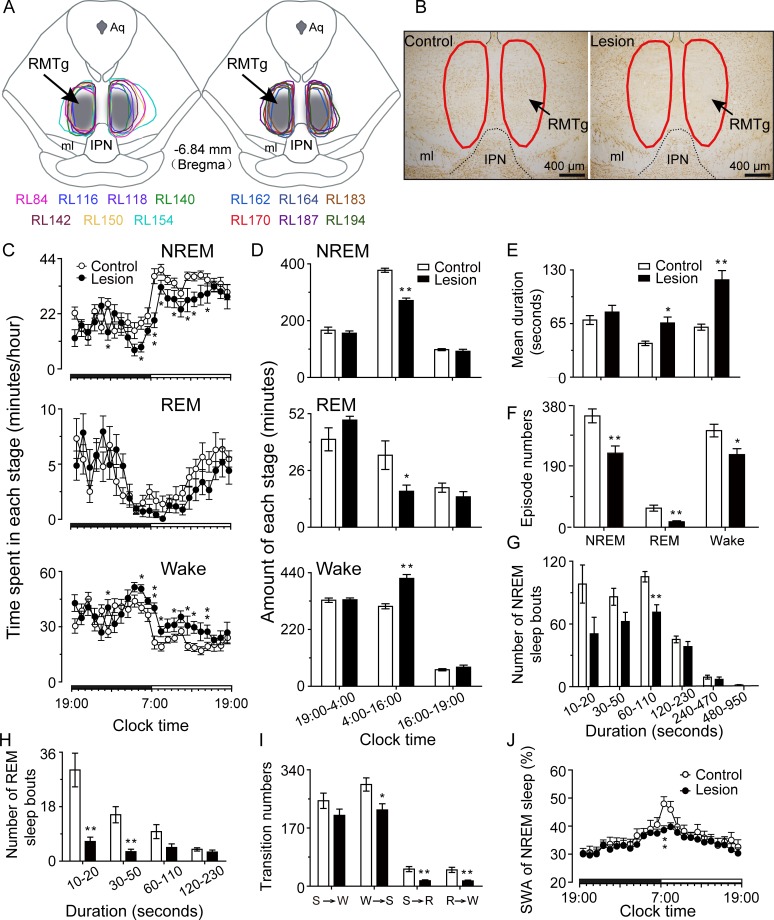
Sleep and wake profiles on day 8 after inducing rostromedial tegmental nucleus (RMTg) lesions with ibotenic acid.(A) Diagrammatic drawing of lesion extent with ibotenic acid in the total 13 lesioned animals whose electroencephalograms (EEGs) were successfully collected after 8 days (RL84, RL116, RL140, RL142, RL162, RL164, RL183, and RL170, n = 8), 16 days (RL140, RL142, RL164, RL170, RL150, RL154, RL187, and RL194, n = 8), 25 days (RL116, RL164, RL183, RL187, RL194, and RL118, n = 6), and 8 days following 6-hour sleep deprivation (RL162, RL164, RL183, and RL170, n = 4) of lesions. The lesioned rats were numbered with the same color characters as the closed curves. The bilateral shaded areas indicate the RMTg area. (B) Photographs of representative coronal sections from a control (left) and a lesioned (right) rat by NeuN staining. The parts with red circles show the location of the RMTg. IPN, interpeduncular nucleus; ml, medial lemniscus. (C) Hourly amount of non-rapid eye movement (NREM) and rapid eye movement (REM) sleep and wakefulness. (D) Total sleep–wake amount during the 9-hour dark period (19:00–04:00 hours), the subsequent 12-hour period (04:00–16:00 hours) and the 3-hour light period (16:00–19:00 h). (E–I) Sleep–wake architecture during 04:00 to 16:00 hours. Mean duration (E) and total episode numbers (F) of NREM and REM sleep and wakefulness; episode spectrum of NREM (G) and REM (H) sleep; transitions between S (NREM sleep), W (wakefulness), and R (REM sleep) stages (I). (J) Hourly slow-wave activity (SWA) (expressed as percentage of delta power [0.5–4 Hz] in NREM sleep per hour) of NREM sleep. *p < 0.05, **p < 0.01 versus controls. Control (n = 9); lesion (n = 8). The horizontal filled and open bars on the x-axes indicate the 12-hour dark period and the 12-hour light period, respectively. Underlying data can be found in S1 Data.